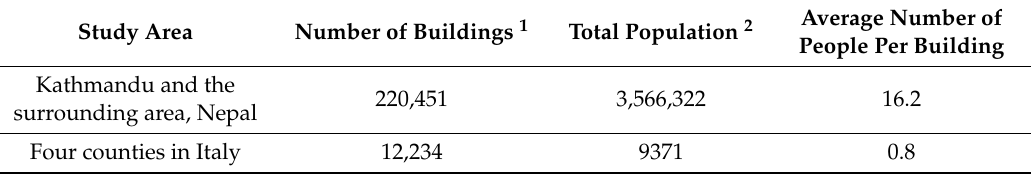
Table 5. The building numbers and population in the study areas of the two earthquake events.